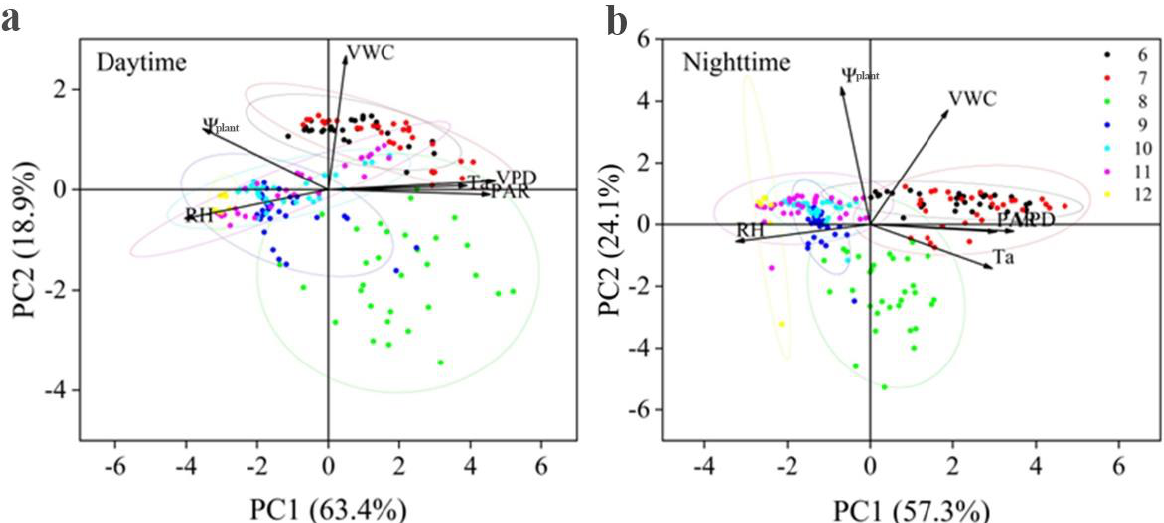
Figure 7. Principal component analysis diagram of environmental factors’ contribution to sap flow. ( a ) The left side is the response of sap flow to various environmental factors during the day, and ( b ) the right side is the response of sap flow to various environmental factors at night. Different colored dots represent different months. RH: relative humidity; Ta: air temperature; PAR: photosyntheti- cally active radiation; VPD: vapor pressure deficit; VWC: volumetric water content; Ψ plant : plant wa- ter potential. Table 3. Results of principal component analysis of environmental factors.